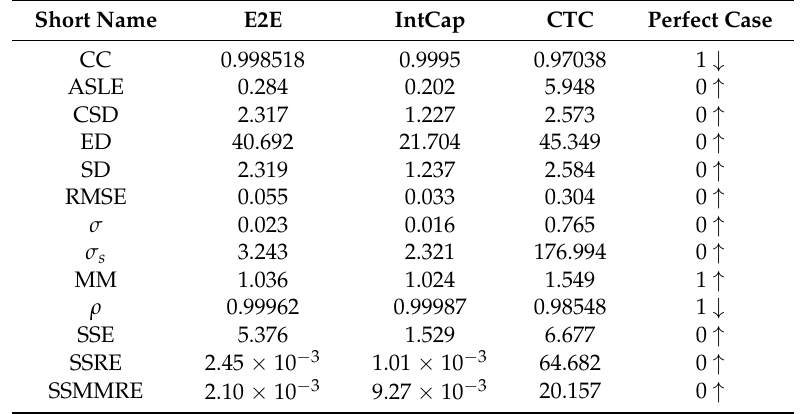
Figure 6. Sister units FRA test results for MF range: ( a ) E2E and IntCap; ( b ) CTC. Table 4. Numerical indices results for sister units (frequency range 4 kHz–115 kHz).